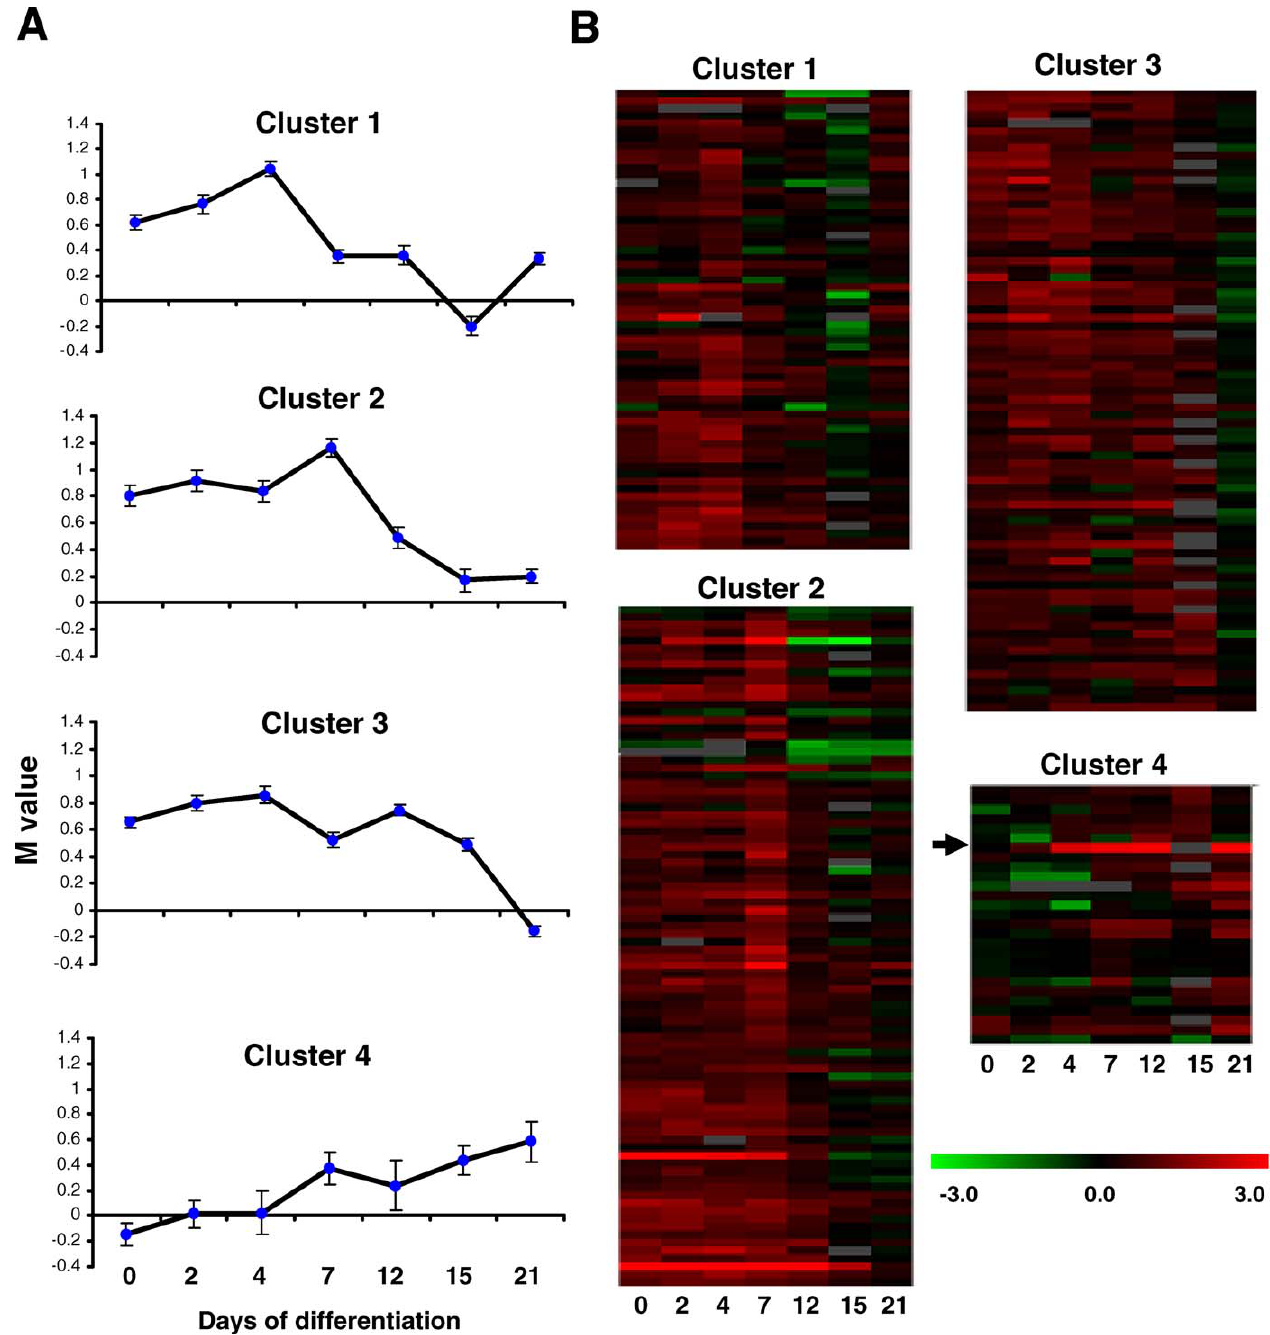
Figure 5. Genes Are Silenced at Widely Differing Times during Differentiation of Female ES Cells (A) X-linked genes on the array were separated into four clusters on the basis of their patterns of change in female:male expression ratio (M values) during ES cell differentiation. Median values ( 6 SE) for each cluster at each time point are shown. Changes in M value are attributable to the progressive inactivation of genes on one of the two female Xs. (B) Heat maps for each gene, with female:male expression ratio colour-coded from green (lowest) to red (highest) as shown on the coloured bar (lower right). Xist (cluster 4, arrowed) shows relatively strong expression in female cells from early in differentiation.